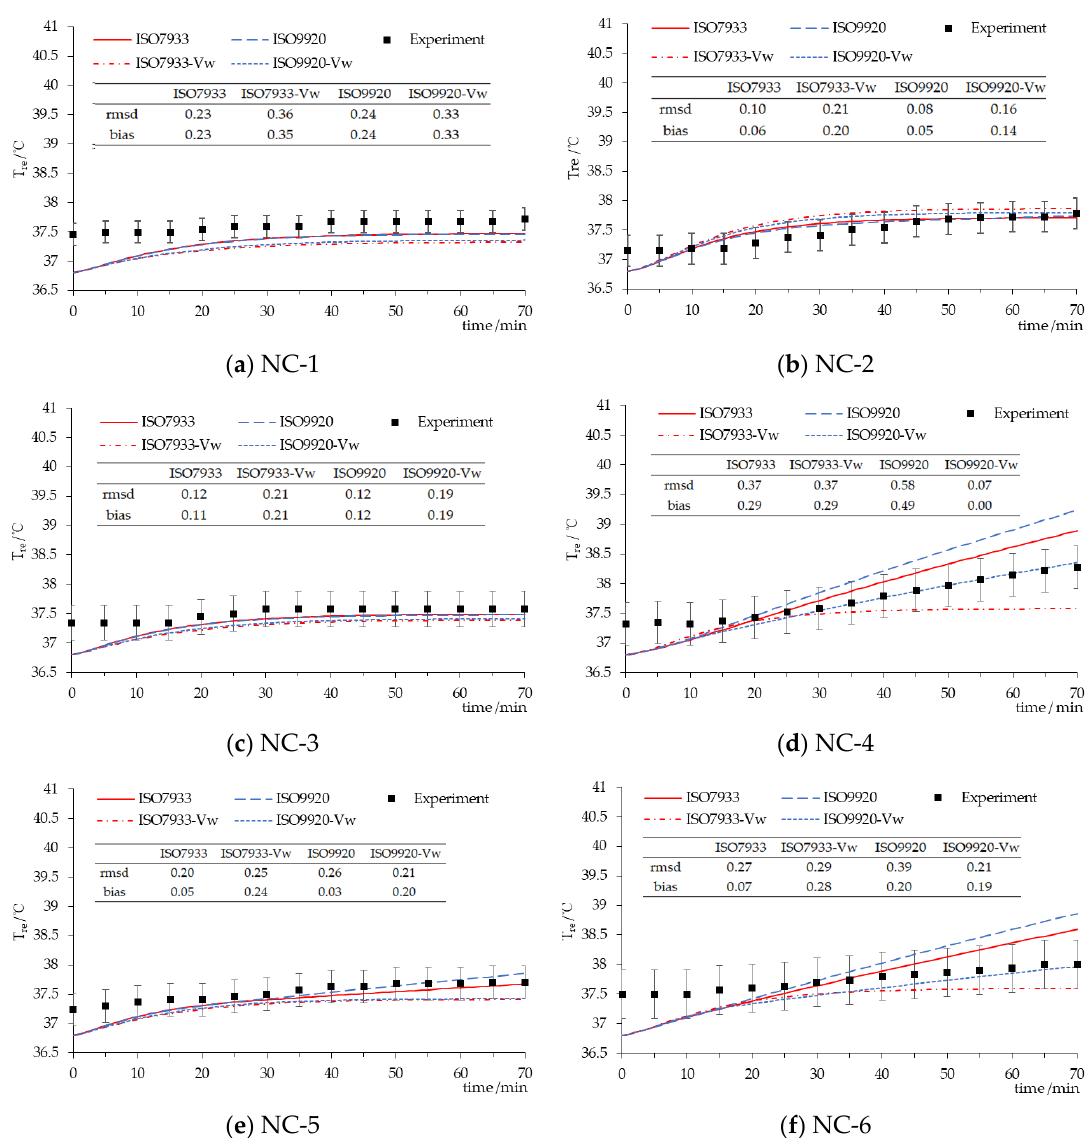
Figure 3. Time-course changes in the rectal temperature for NC. Experiment—the mean rectal temperature observed in participants, ISO7933—the rectal temperature predicted by the PHS model with the clothing correction algorithm of ISO 7933, ISO7933- v w —the rectal temperature predicted by the PHS model with the clothing correction algorithm of ISO 7933 on adding the walking speed input parameter, ISO9920—the rectal temperature predicted by the PHS model with the clothing correction algorithm of ISO 9920, ISO9920- v w —the rectal temperature predicted by the PHS model with the clothing correction algorithm of ISO 9920 on adding the walking speed input parameter.( a ) clothing insulation 0.63 clo in 20 °C; ( b ) clothing insulation 0.63 clo in 40 °C; ( c ) clothing insulation 1.08 clo in 20 °C; ( d ) clothing insulation 1.08 clo in 40 °C; ( e ) clothing insulation 1.11 clo in 20 °C; ( f ) clothing insulation 1.11 clo in 30 °C.